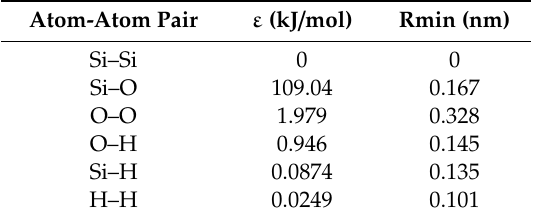
Table 3. Lennard-Jones pair potential parameters used for the optimization of the mesopore model.